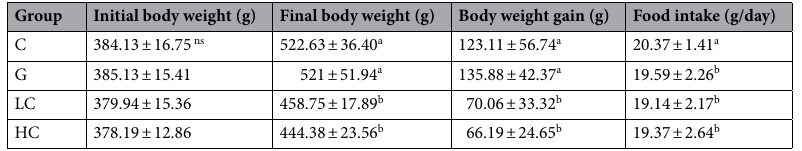
Table 1. Initial body weight, final body weight and food intake of each group. Values represent mean ± SD, n = 8. ns: not significant; Means for a variable with different letters (a and b) within a column differ significantly ( p < 0.05). C, control; G, d-galactose-induced aging; LC, d-galactose injection with 10% cacao powder mixed diet; HC, d-galactose injection with 16% cacao powder mixed diet.